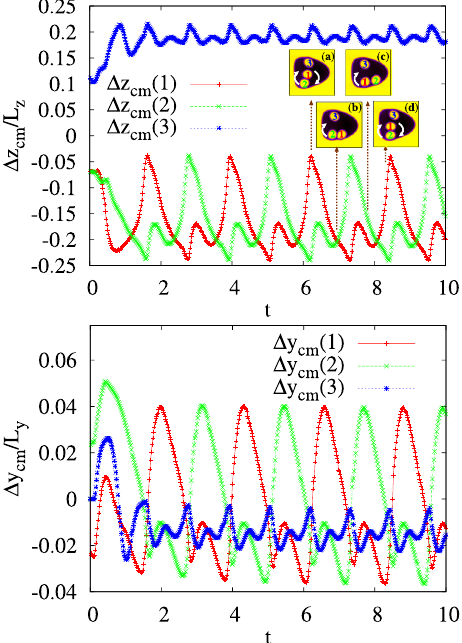
Fig. 7 Time evolution of Δ z cm and Δ y cm in a three-core emulsion. Cores 1 and 2 show a periodic motion around a common center of mass in the bottom region of the emulsion while core 3 travels persistently along a circular path con fi ned in the upper part. The inset shows four instantaneous con fi gurations of ϕ i during a periodic cycle. White arrows denote the trajectories of the cores. Snapshots are taken at t = 6.22 × 10 5 ( a ), t = 6.96 × 10 5 ( b ), t = 7.8 × 10 5 ( c ), t = 8.42 × 10 5 ( d ).